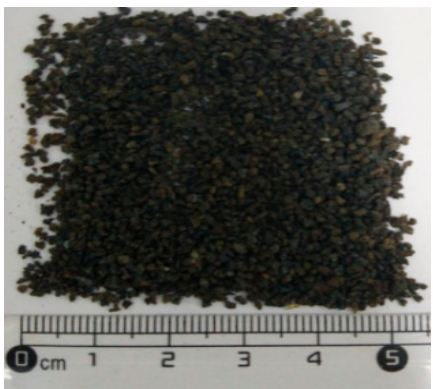
Figure 1. Scoria adsorbent.